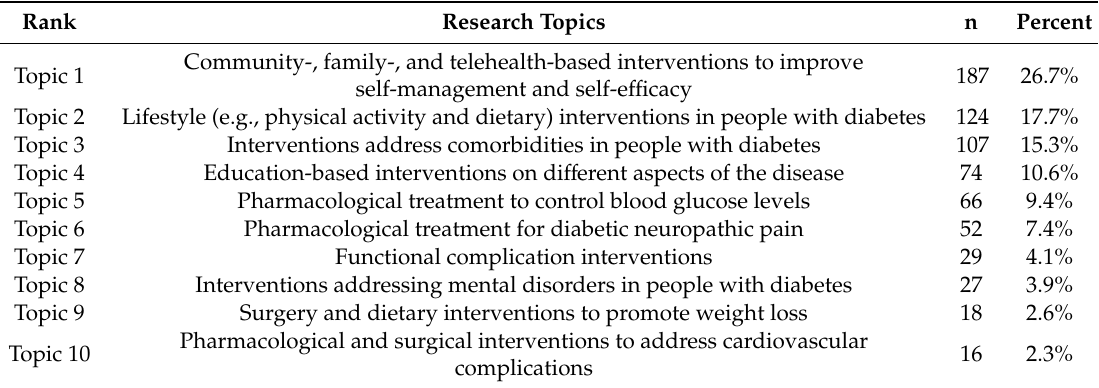
Table 3. Ten research topics classified by Latent Dirichlet Allocation.